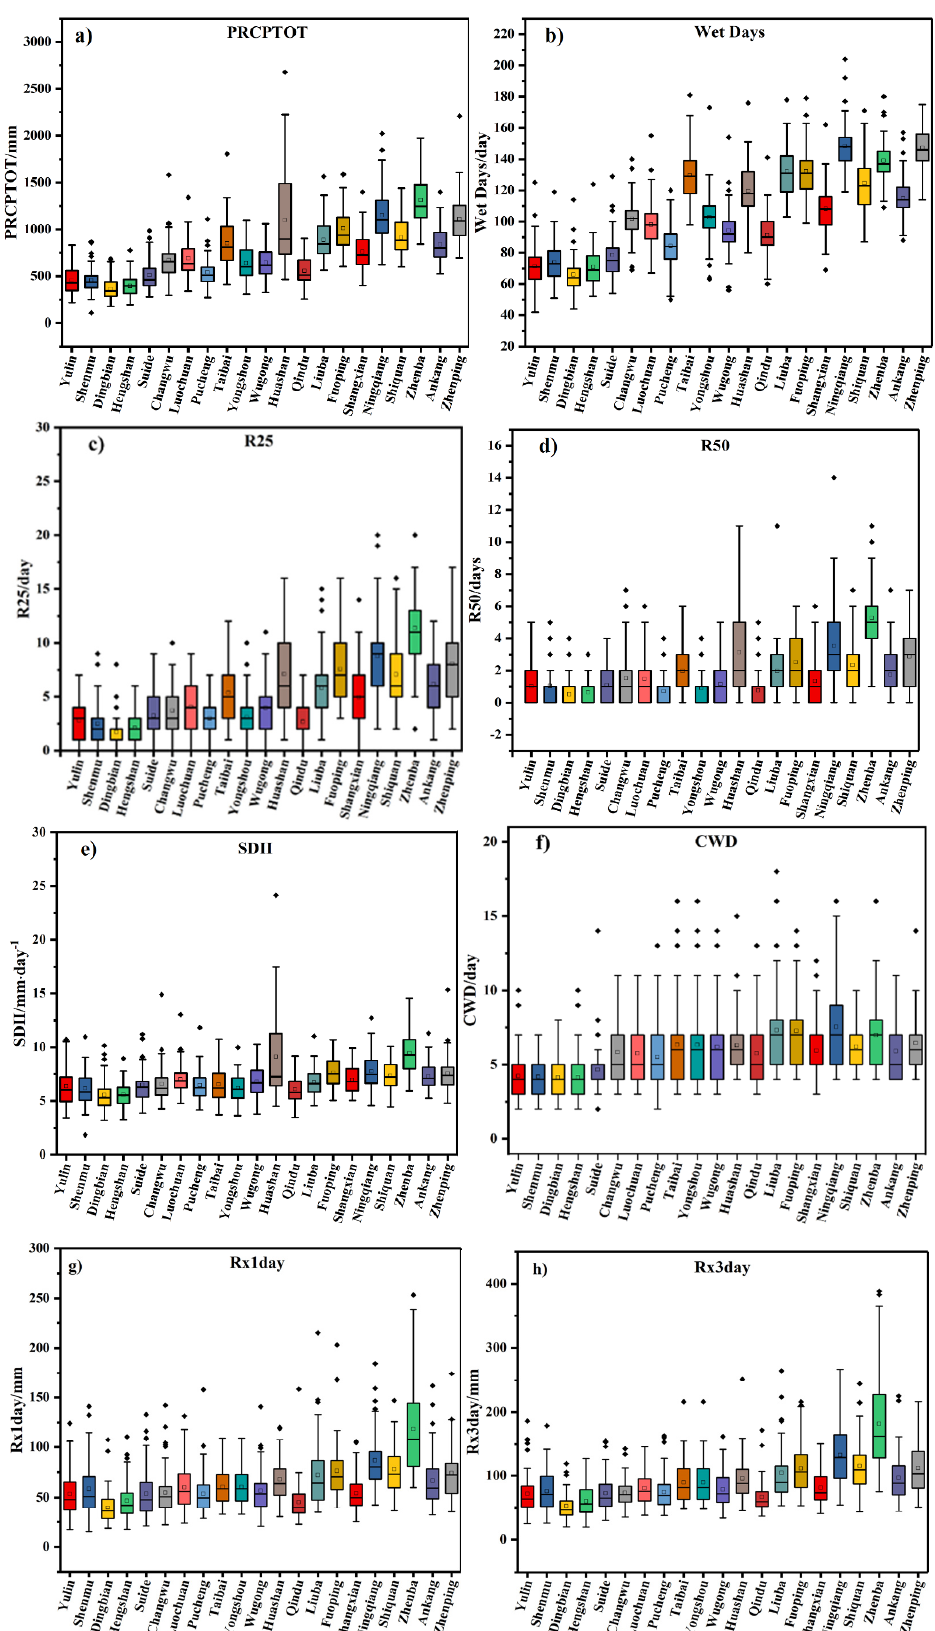
Figure 4. The values of ( a ) PRCPTOT, ( b ) wet days, ( c ) R25, ( d ) R50 and ( e ) SDII, ( f ) CWD, ( g ) Rx1day, ( h ) Rx3day at the 21 stations at the annual